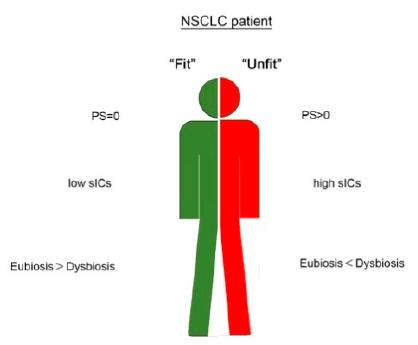
Figure 5. Schematic representation of a potential string of predictors useful to discriminate fit (in green) and unfit (in red) NSCLC patient.